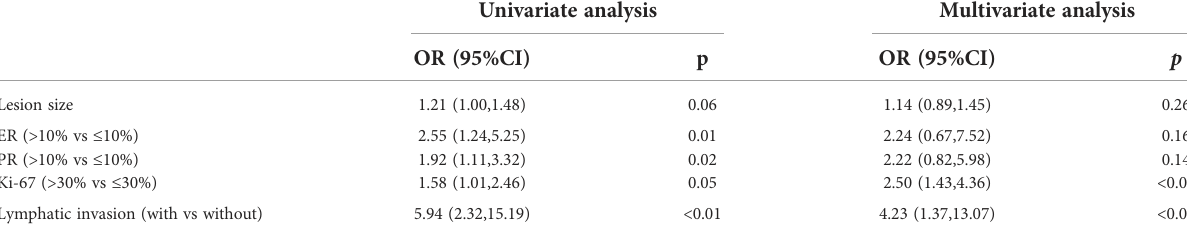
TABLE 2 Logistic regression for lesion size, lymphatic invasion, nerve invasion, ER, PR and